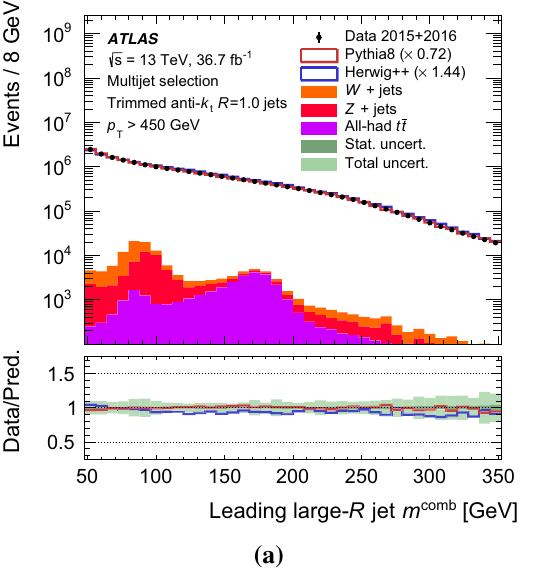
specific sample to which it applies. Systematic uncertainties are indi- cated as a band in the lower panel and include all experimental uncer- tainties related to the selection of events, as well as the reconstruction and calibration of the large- R jet